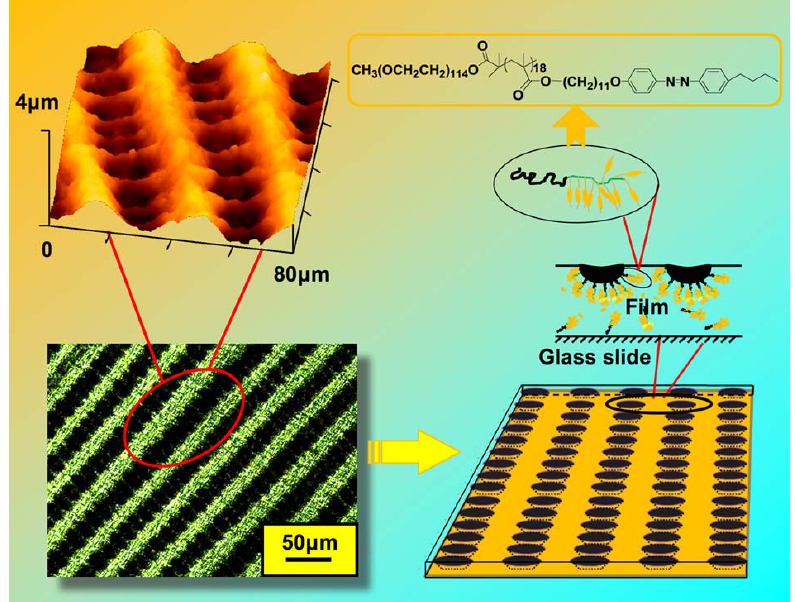
Figure 23. Fabrication of regularly patterned micropores with an amphiphilic PRBC by spin coating under a dry